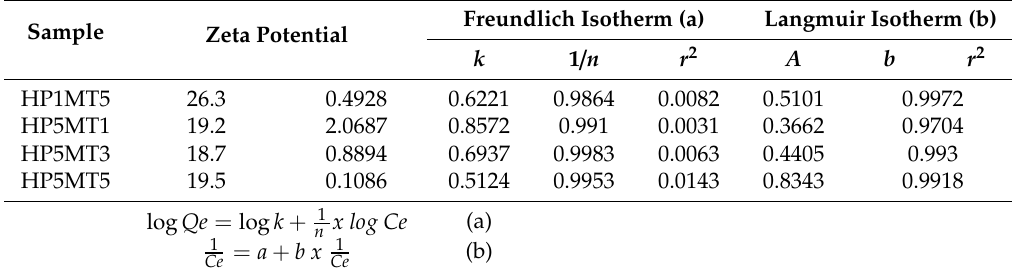
Table 6. Constants obtained by linearizing the Freundlich and Langmuir equations.